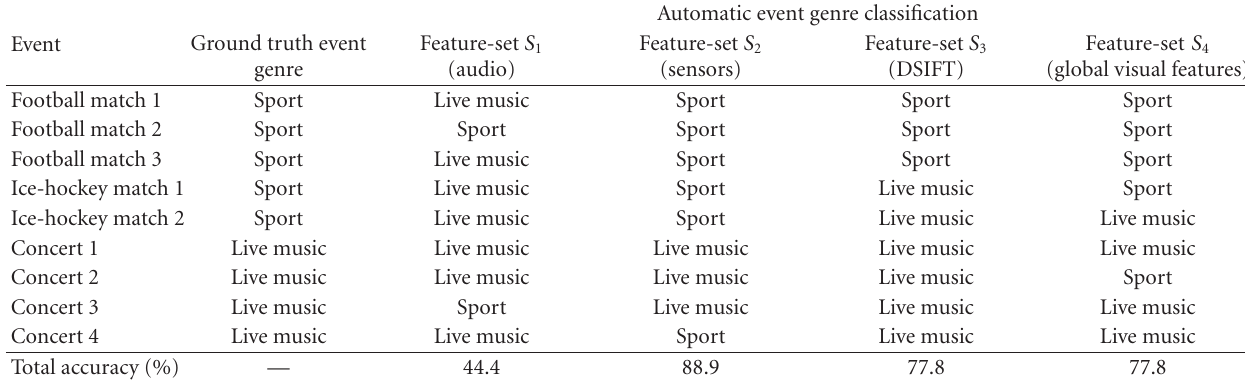
Table 3: Performance comparison for the event genre classification task using di ff erent feature-sets.